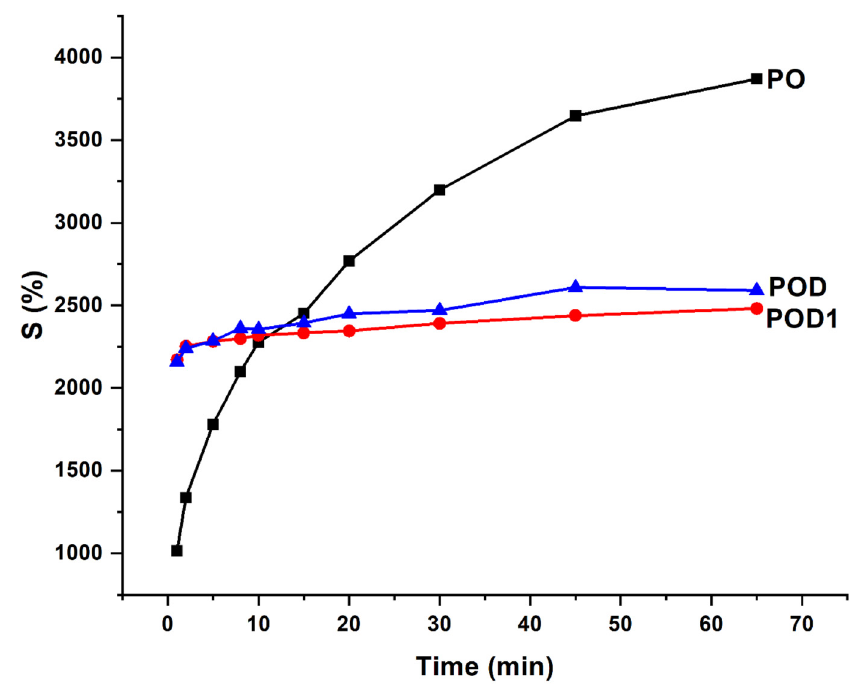
Figure 7. Swelling kinetic of the hydrogels in water.